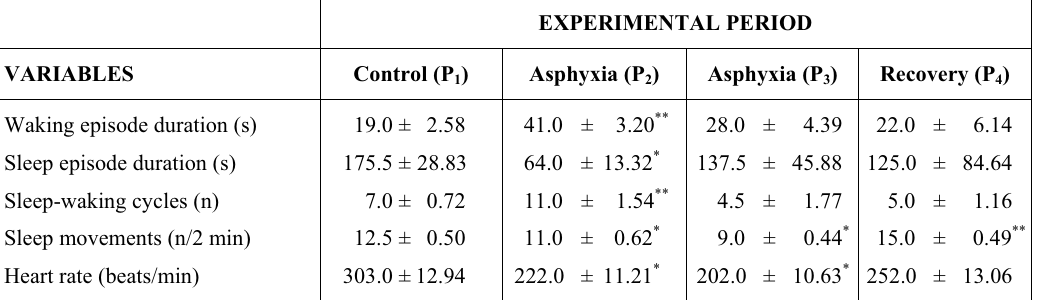
TABLE 1 - Sleep parameter results in newborn rats. Median ± SE values for 8 rats (6-48h old) during a